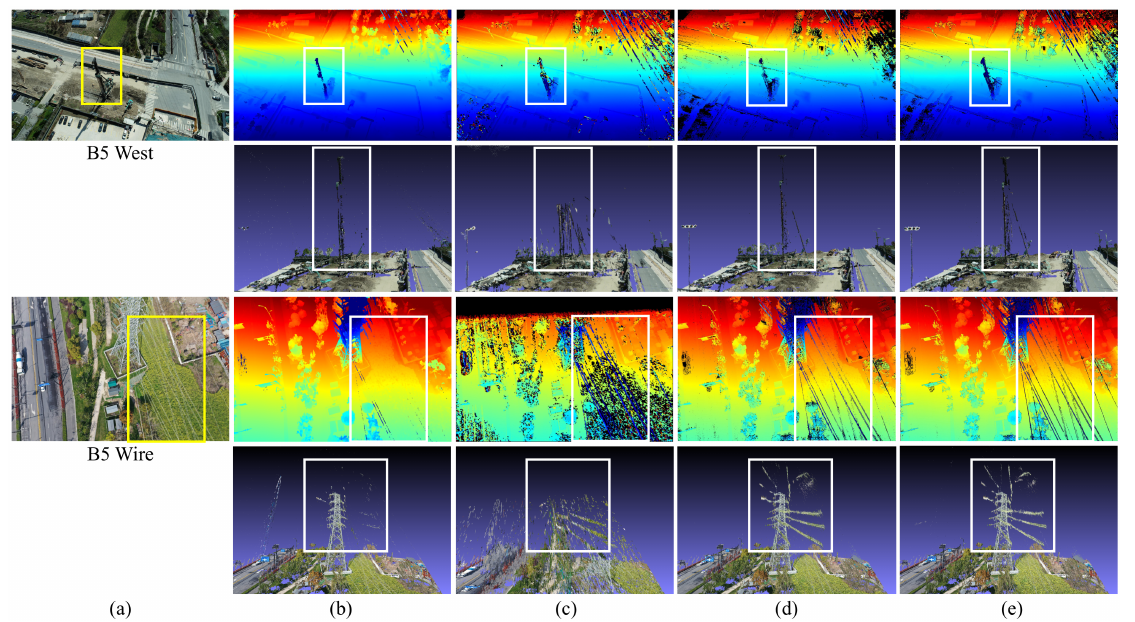
Figure 3. ( a ) A source image view for each case of “ZJU Fan”, “B5 Tower”, “B5 West” and “B5 Wire”. ( b ) The depth map results of ACMM [50] and their corresponding point clouds by projecting the depths forward to 3D space. ( c ) The depth maps and point clouds of OpenMVS [56]. ( d ) The depth maps and point clouds of COLMAP [26]. ( e ) Our results of depth maps and point clouds, which turn out to be the best in both details and